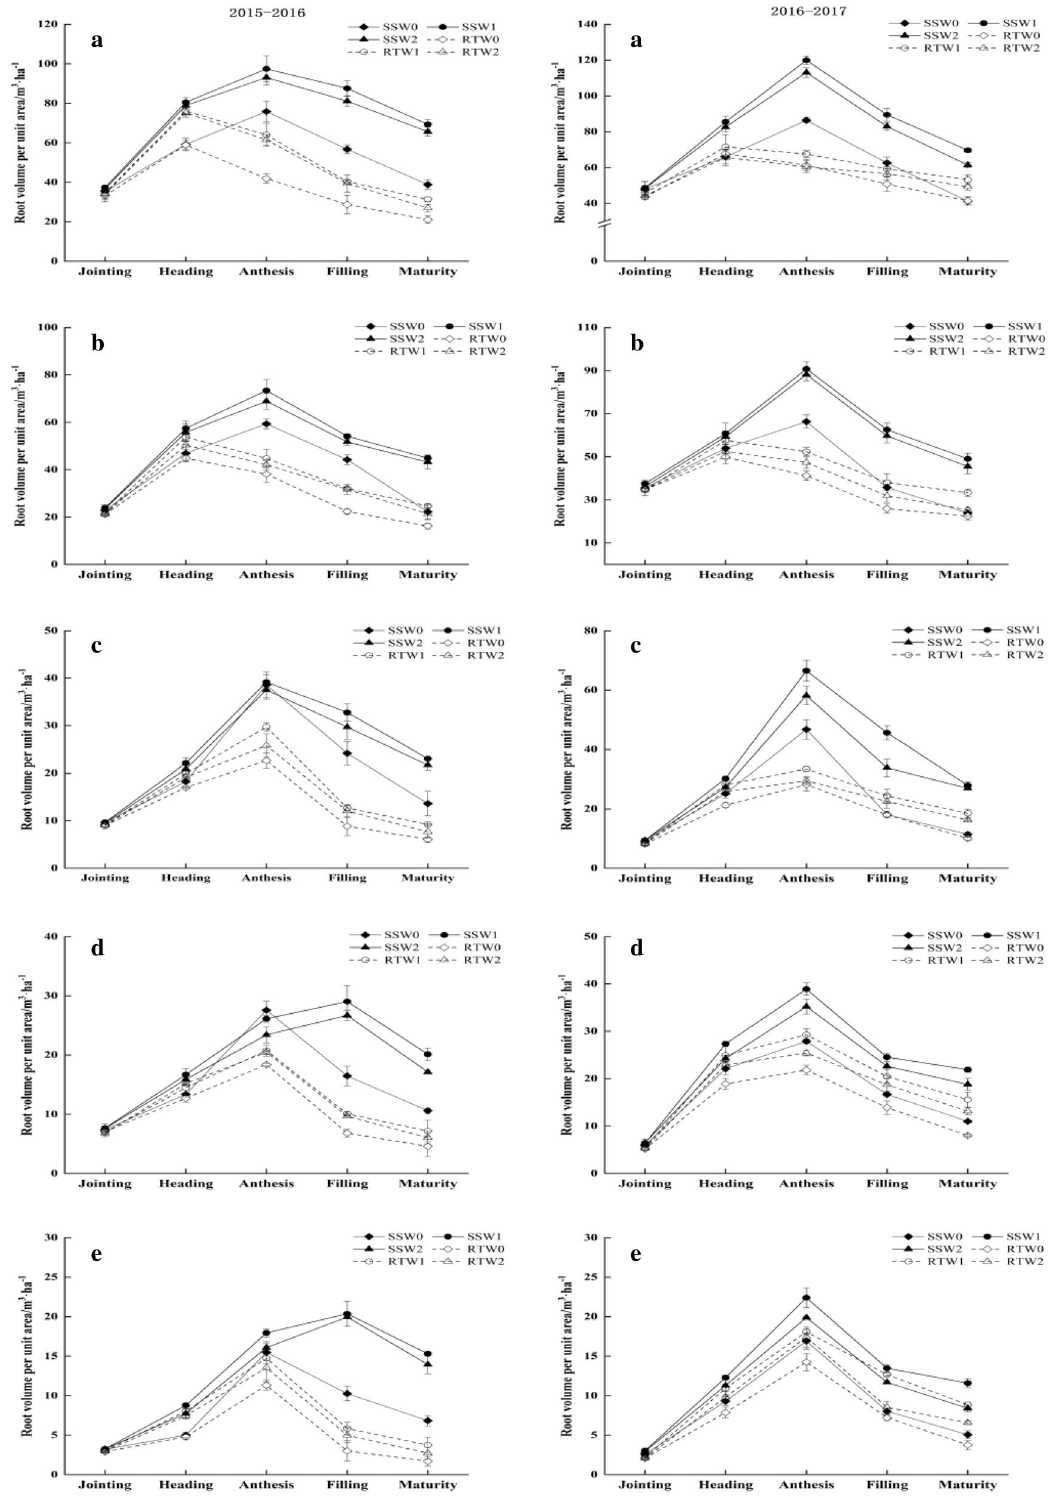
Figure 4. Effects of tillage practice and irrigation regime on the root volume per unit area of winter wheat in different soil winter wheat. For TDRW and TRL, the correlation coefficient in the middle and late growth periods was rela- tively large, while for TRSA and TRV, there was little difference during the growth period except at the heading stage. All the correlation coefficients reached a maximum at the heading stage. In addition, in terms of their cor- relations with grain yield, the root parameters at the early growth stage ranked as TRV > TRSA > TRL > TDRW,